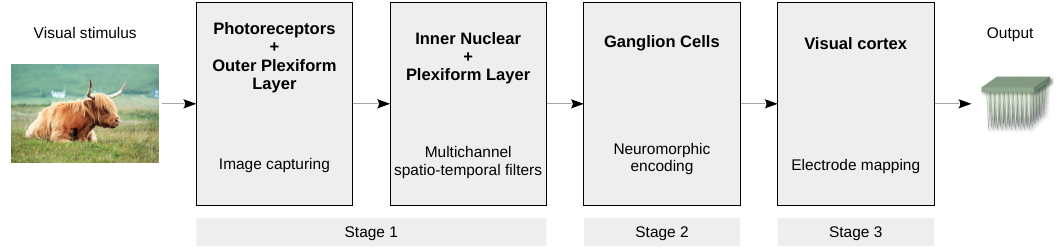
Figure 2. Flowchart of the bioinspired retinal model (BIRM) under study. Stage 1 is modelled as a weighted sum of several well-known convolutive spatiotemporal image filters, such as Difference-of-Gaussian (DoG) and Laplacian-of Gaussian (LoG) filters. Stage 2 is modelled by the noisy leaky integrate-and-fire model (NLIF). Stage 3, which represents the potential electrode remapping, is beyond the scope of this paper. This figure is a derivative of “Highland cattle, Skye Island” by Qu1m, used under CC BY, and Webvision